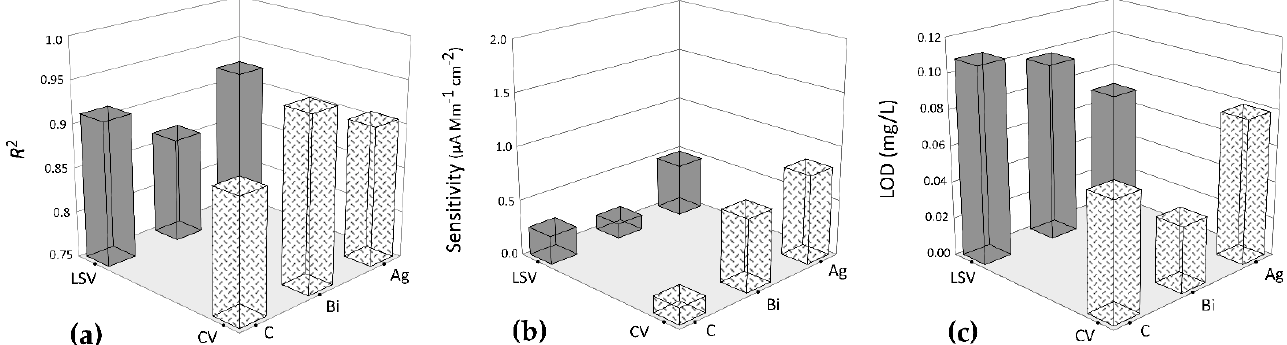
Figure 5. 3D surfaces for performance parameters of three electrode types (C-carbon, Bi-bismuth, and Ag-silver) and two voltammetric techniques (CV and LSV): ( a ) R 2 , ( b ) Sensitivity (µA Mm − 1 cm − 2 ), and ( c ) Limit of Detection (LOD; mg/L).